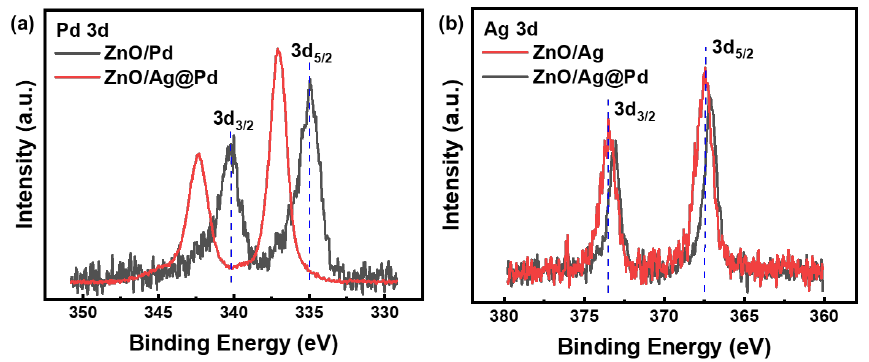
Figure 5. ( a ) Fine-scanned Pd 3d XPS spectras of ZnO/Pd and ZnO/Ag@Pd. ( b ) Fine-scanned Ag 3d XPS spectras of ZnO/Ag and ZnO/Ag@Pd.